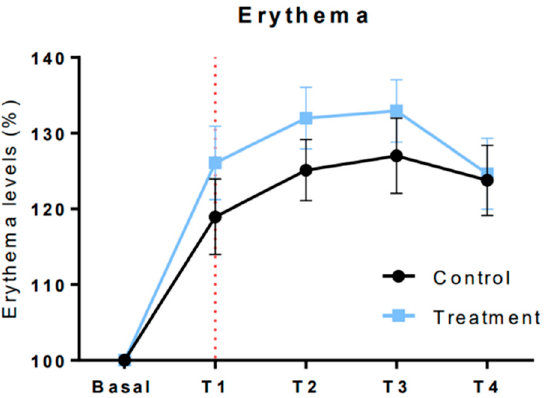
Figure 11. Functional analysis of the anti-irritant effects of mask PBSK-1 and mask PBSK-2 over time. The mean and the standard error of the median are plotted as percentage. A dashed red line is set at T 1 and is indicative of the beginning of each treatment. For statistical significance, a paired t-test was applied to the normalized values of each time point, comparing the treated vs. untreated areas.